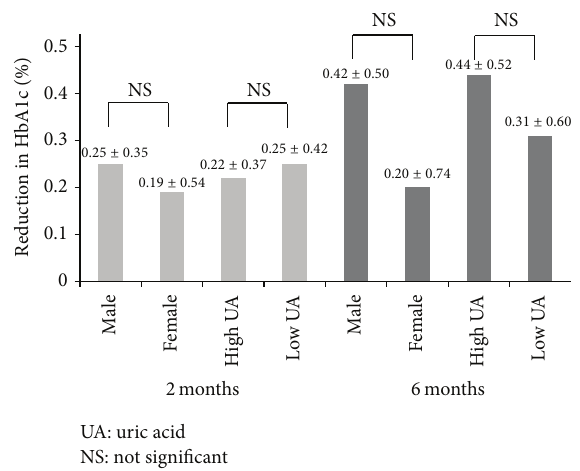
Figure 5: Comparison of the levels of reduction in HbA1c at 2 and 6 months according to sex and serum uric